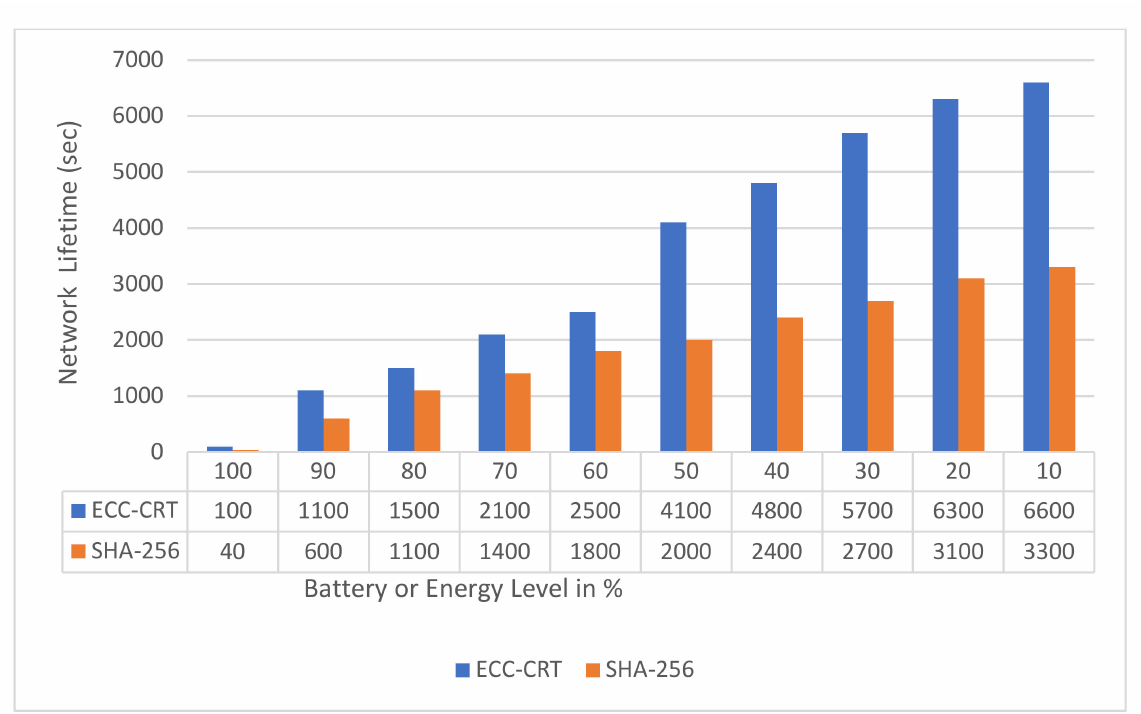
Figure 10. Network lifetime in various battery or energy levels for ECC-CRT and